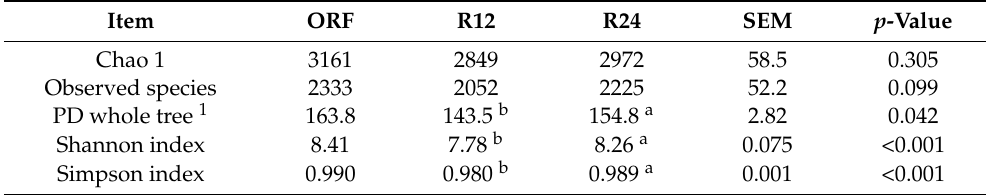
Table 3. Alpha diversity metrics of ruminal bacteria as in vitro rumen fermentation advanced.